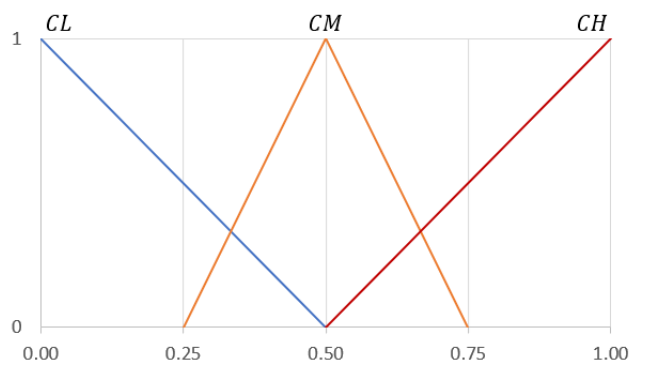
Figure 3. Fuzzy sets for the vehicle available capacity after visiting the customer i